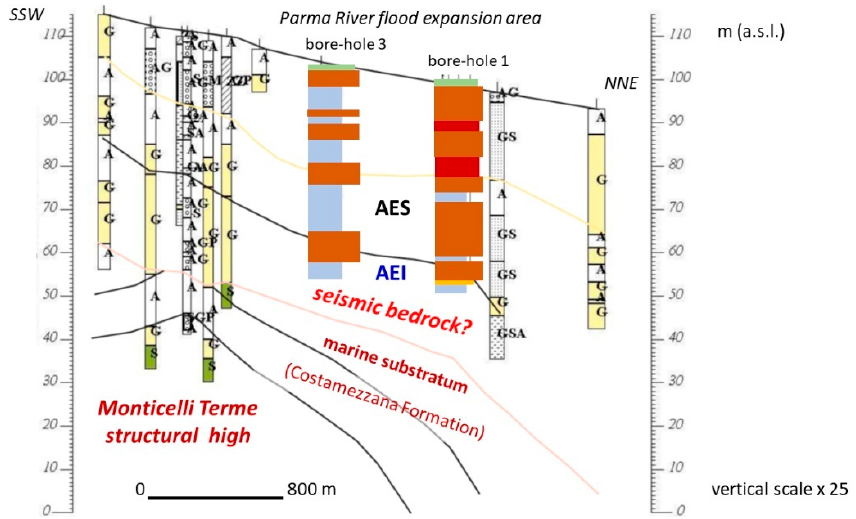
Figure 11. Geological cross-section across the southern side of the Parma River alluvial fan ([27], with modifications).